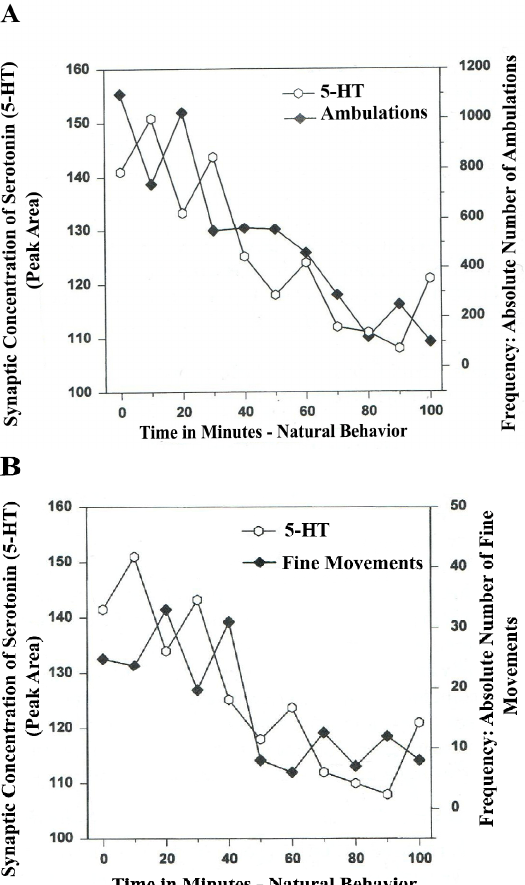
, somotodendrites , 10